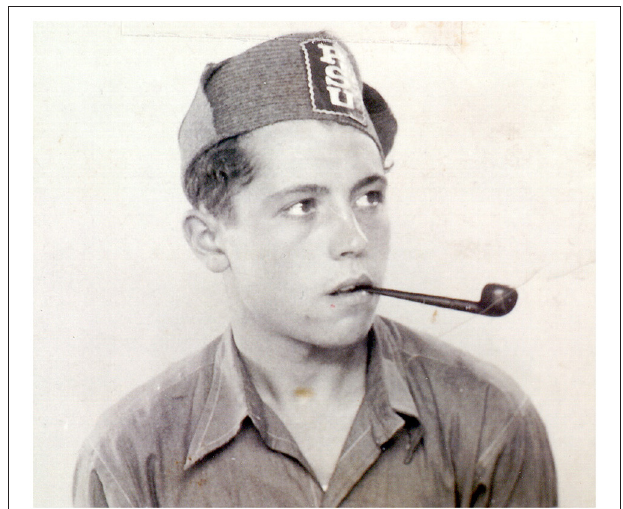
FIGURE 3 | Antonio Cánovas at the beginning of the civil war (1936). Source: Cánovas family archive.